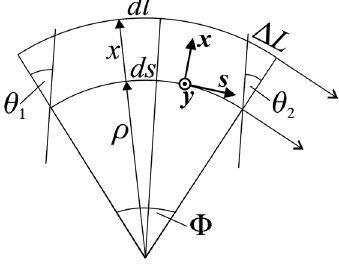
FIG. 1. Bending magnet